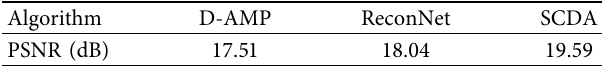
Table 2: Reconstruction accuracy comparison results of D-AMP, ReconNet, and SCDA algorithms (the measurement rate is 0.10).